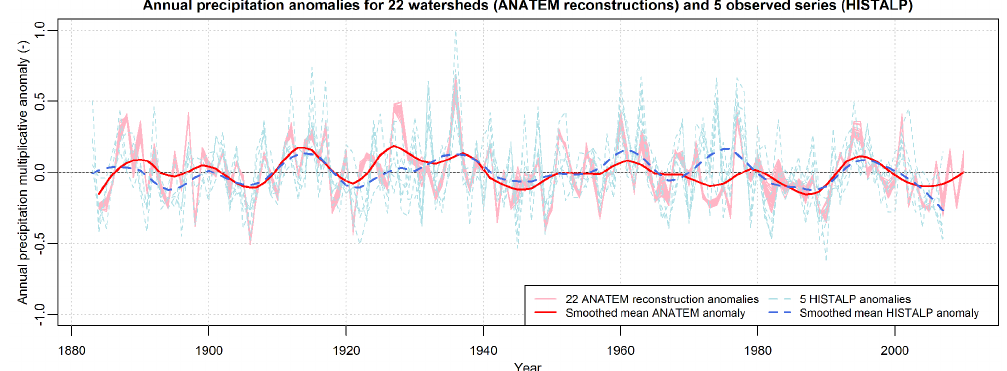
Figure 16. Mean annual precipitation multiplicative anomaly for the 22 watersheds (ANATEM) and five stations (HISTALP). The multi- plicative anomaly for a given year has been computed as the ratio between the annual precipitation for this year and the 1883–2010